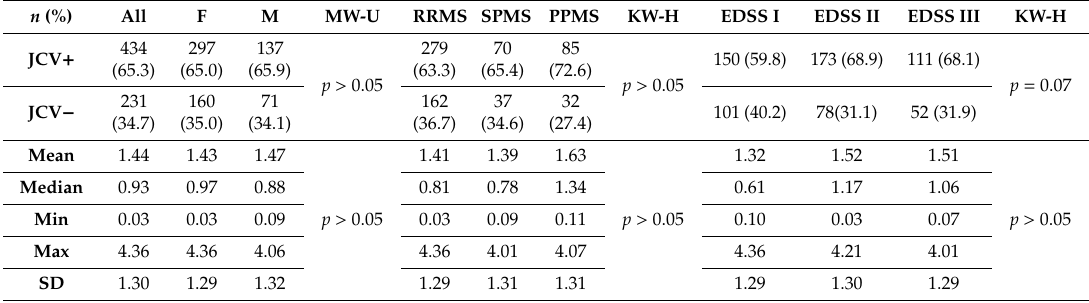
Table 2. Anti-JCV antibody prevalence and antibody index by the patients’ sex, disease course and EDSS score.